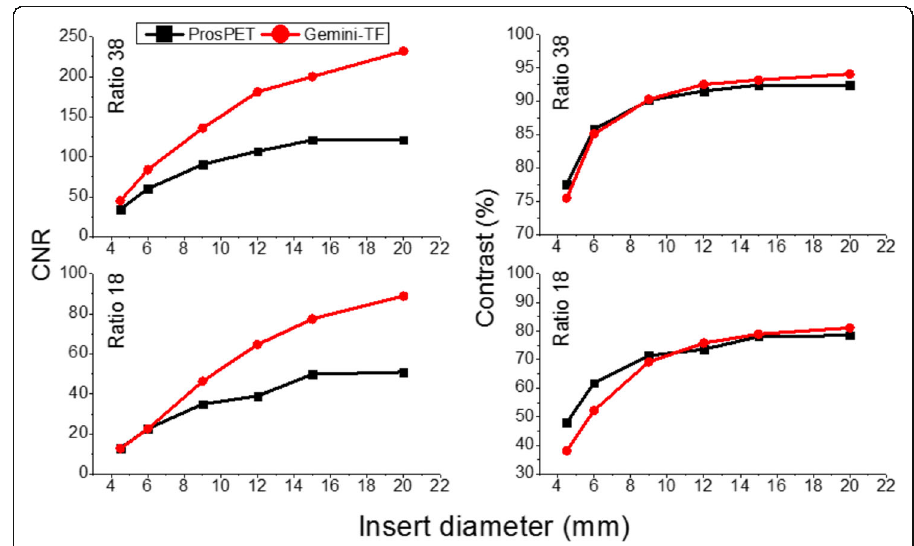
Fig. 14 Left, CNR comparison between the ProsPET system using 8 iterations (attenuation based on CT image and no scatter correction) and the Gemini-TF, for the 6 inserts, and the two insert-to-background ratios 18 and 38, respectively. Right, contrast (%) comparison also for all 6 inserts and two ratios